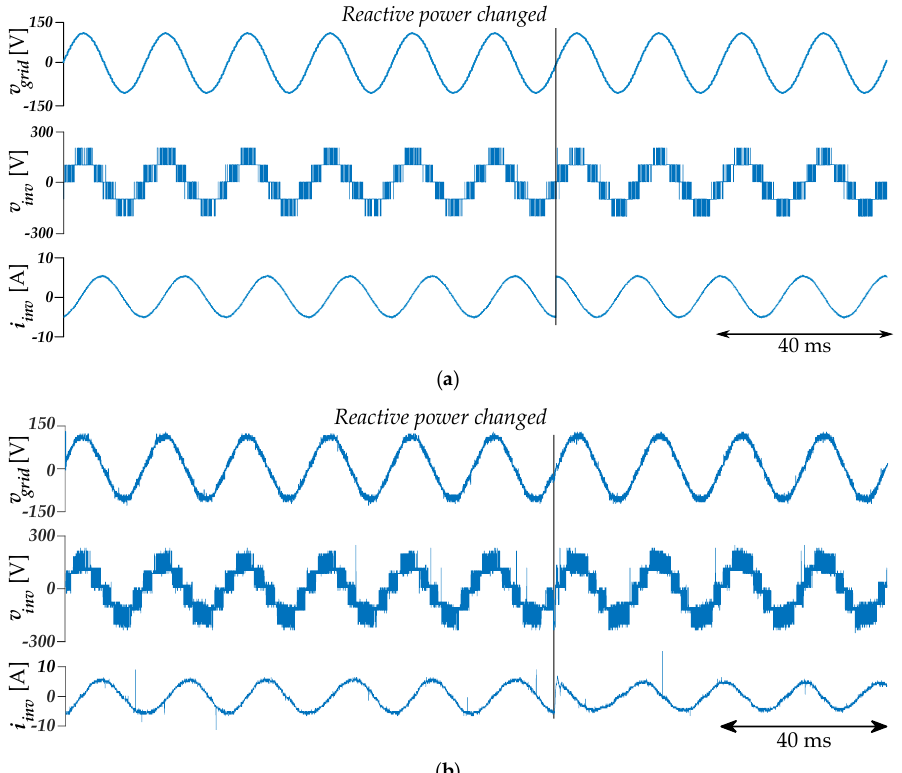
Figure 15. Transient state from inductive to capacitive operation. ( a ) Simulated waveforms. ( b ) Experimental